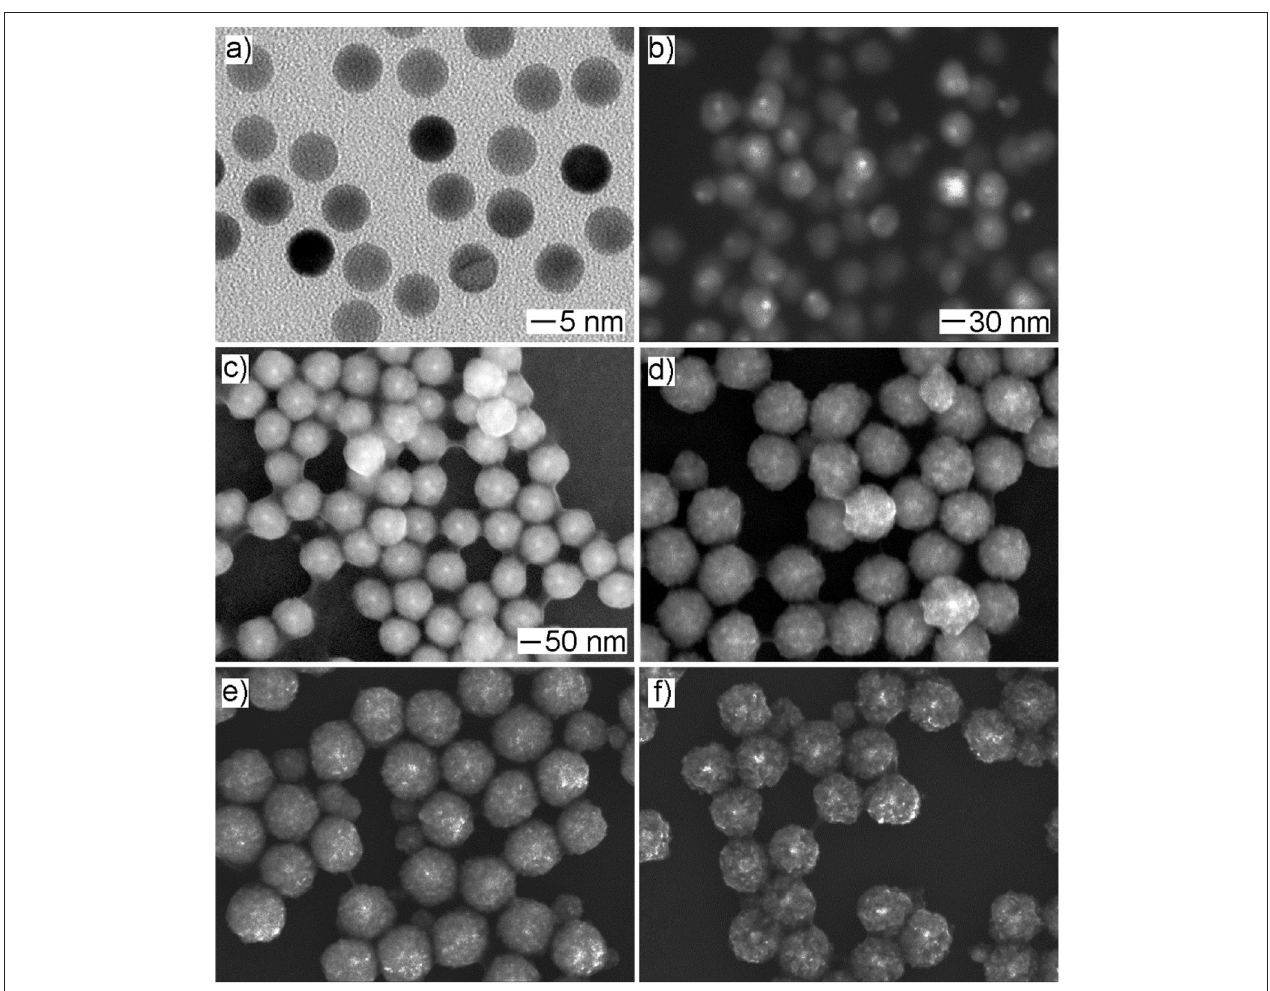
FIGURE 1 | The time-lapse study of the growth process for Au@Cu x O core–shell nanostructures. (a–e) The SEM images and (f) the corresponding XRD patterns of the products obtained at different reaction stages of the standard procedure: (a) 5min, (b) 15min, (c) 30min, (d) 45min, and (e) 60min,